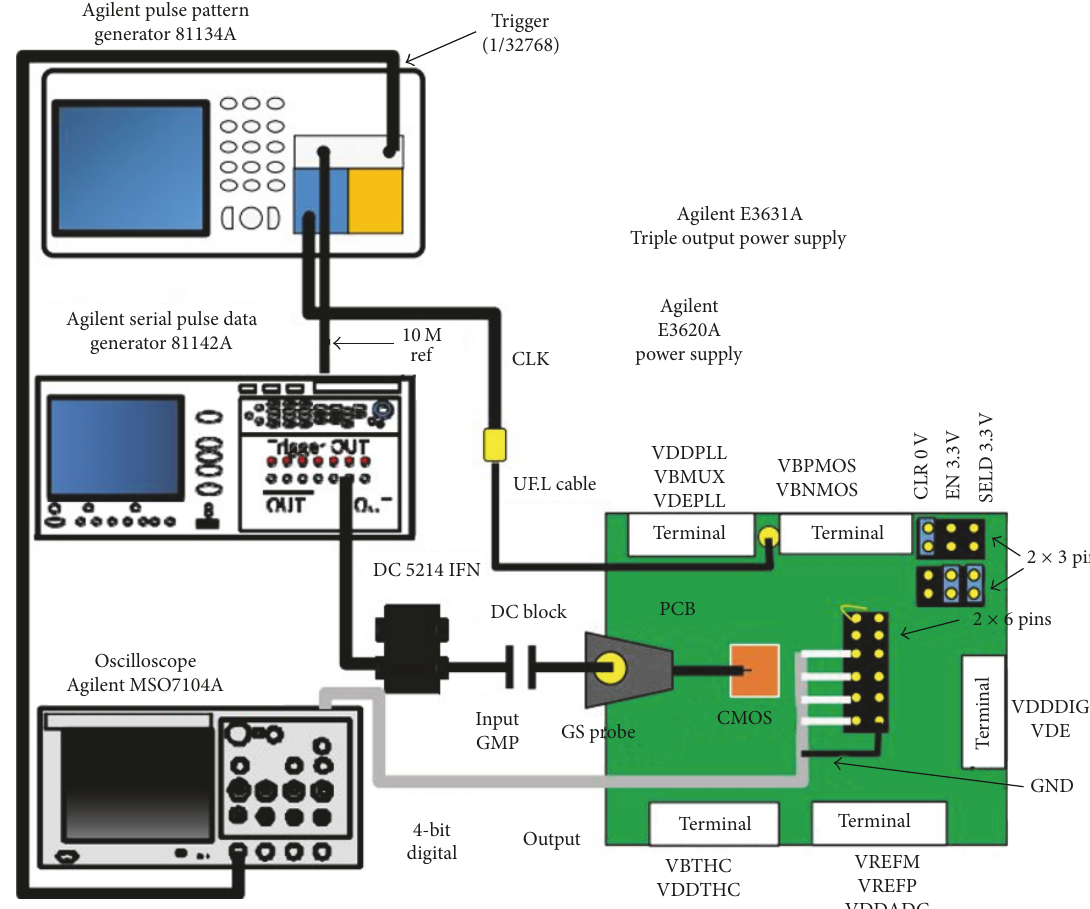
Figure 30: GMP equivalent time sampling measurement setup of Hiroshima University [33]. Image copyright IEEE, used with